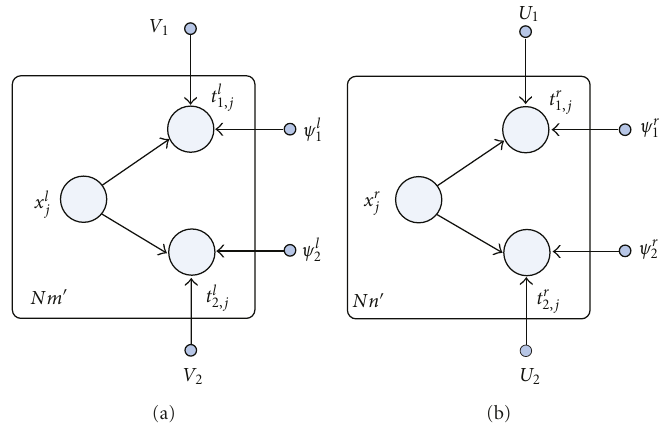
Figure 2: Probabilistic graphical model for 2DCCA, (a) left model and (b) right